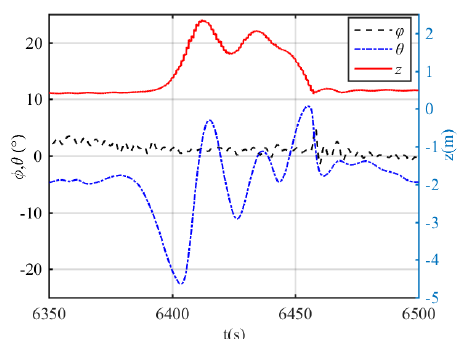
Figure 14. Depth control results. The red line is the depth, the blue line is the pitch angle, and the black line is the roll angle. Figure 15. Heading control results. The red line is the heading angle and the red line is the desired heading.